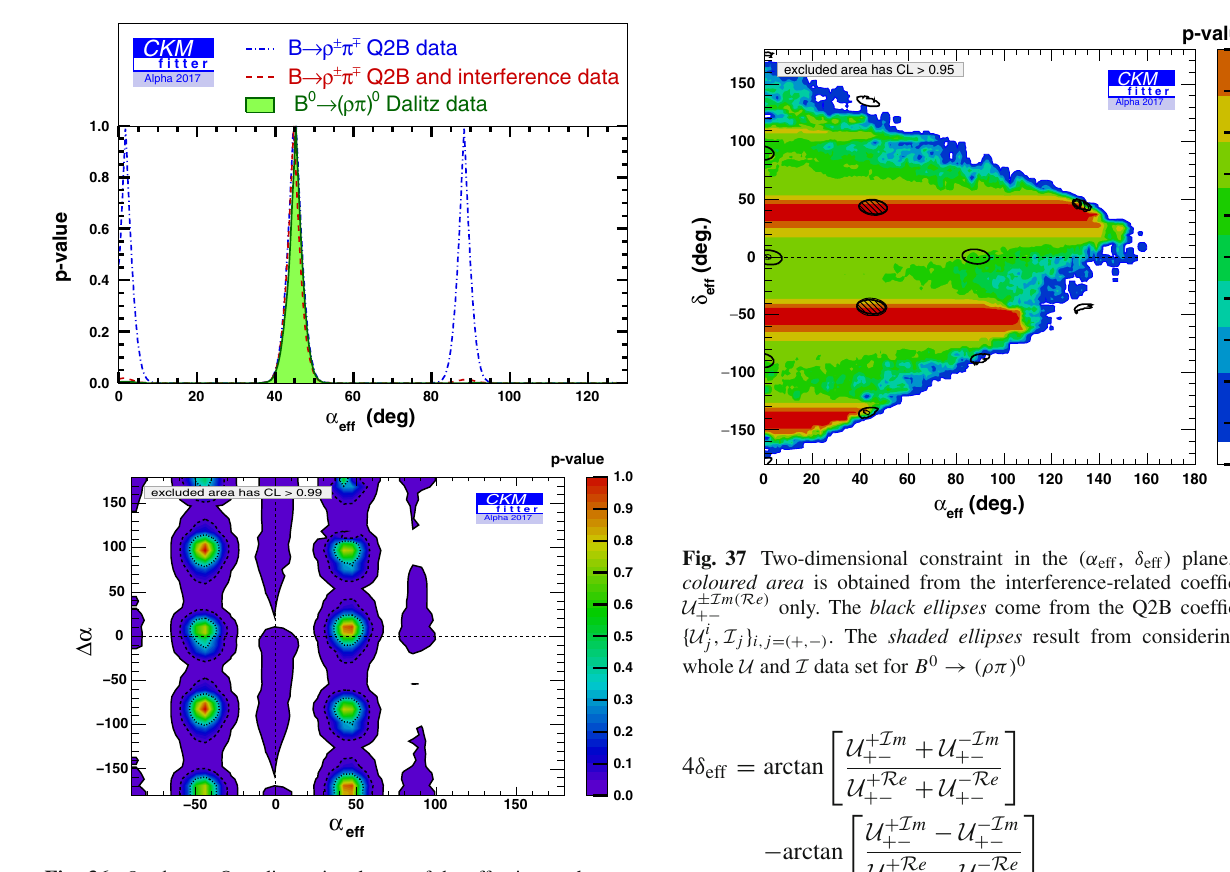
Fig. 36 On the top One-dimensional scan of the effective angle aver- age α eff using B 0 → (ρπ) 0 Dalitz data. The dot-dashed curve is obtained when using only the B 0 → ρ ± π ∓ quasi-two-body observ- ables, { U + − , U − − , U + + , U − + , I + , I − } . The dashed curve includes also the ± R e ( I m ) , I R e ( I m ) } . On the bottom interference-related observables, { U +− +− Two-dimensional constraint in the ( α eff ,Δα ) plane obtained using the whole U and I observables. Contrary to other similar figures in this arti- cle (where the excluded region is above 2 σ or 95% CL), the excluded region corresponds here to a confidence level above 3 σ (99% CL) in order to show the suppressed solution around ( 90 ◦ , 0 ◦ )